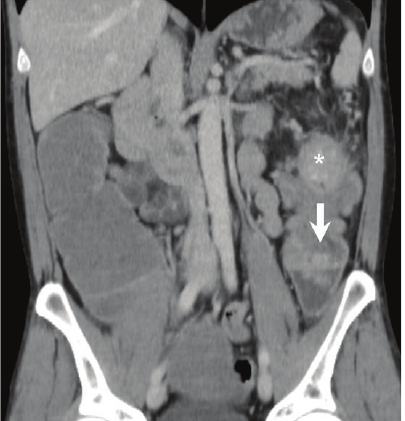
Figure 2: CT scan of abdomen (coronal section) showing intussus- ception of a polypoid lead point ( ∗ ) into the distal descending colon (arrow indicates direction of intussusception).